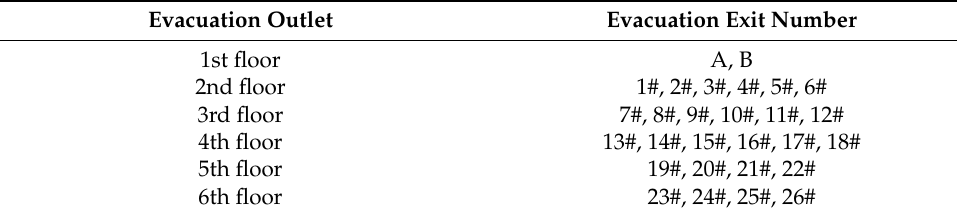
Table 1. Library evacuation channel number.